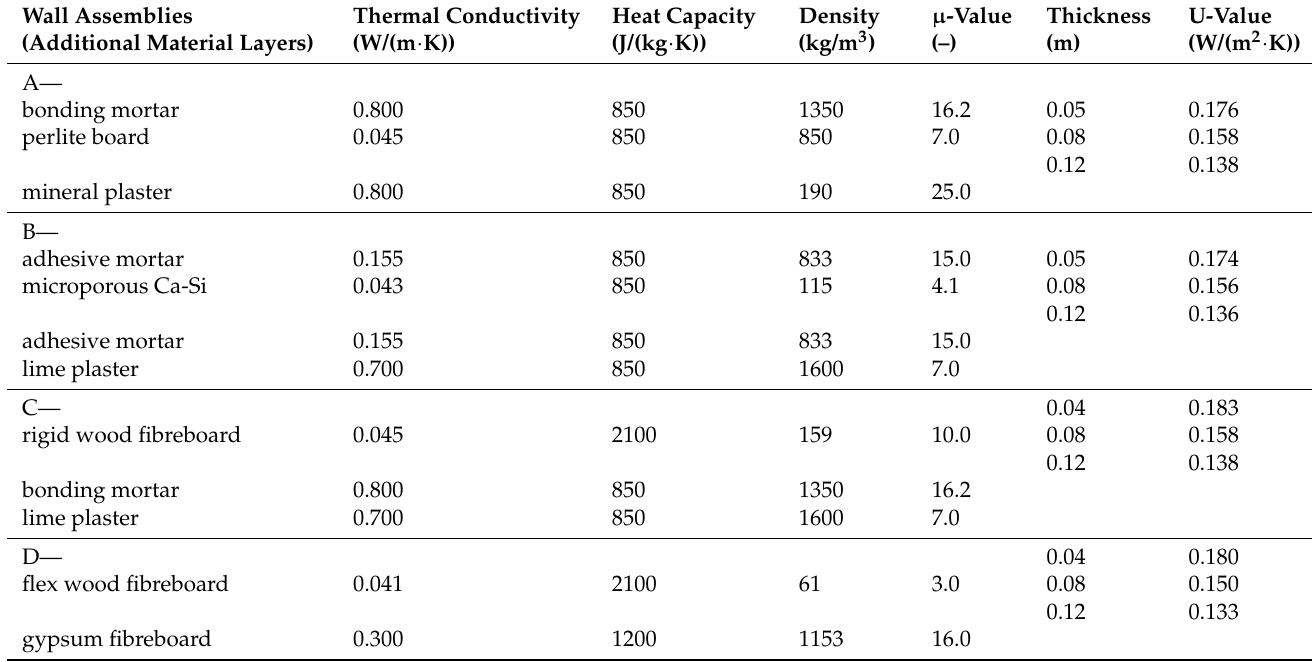
Table 1. Wall assembly configurations used in